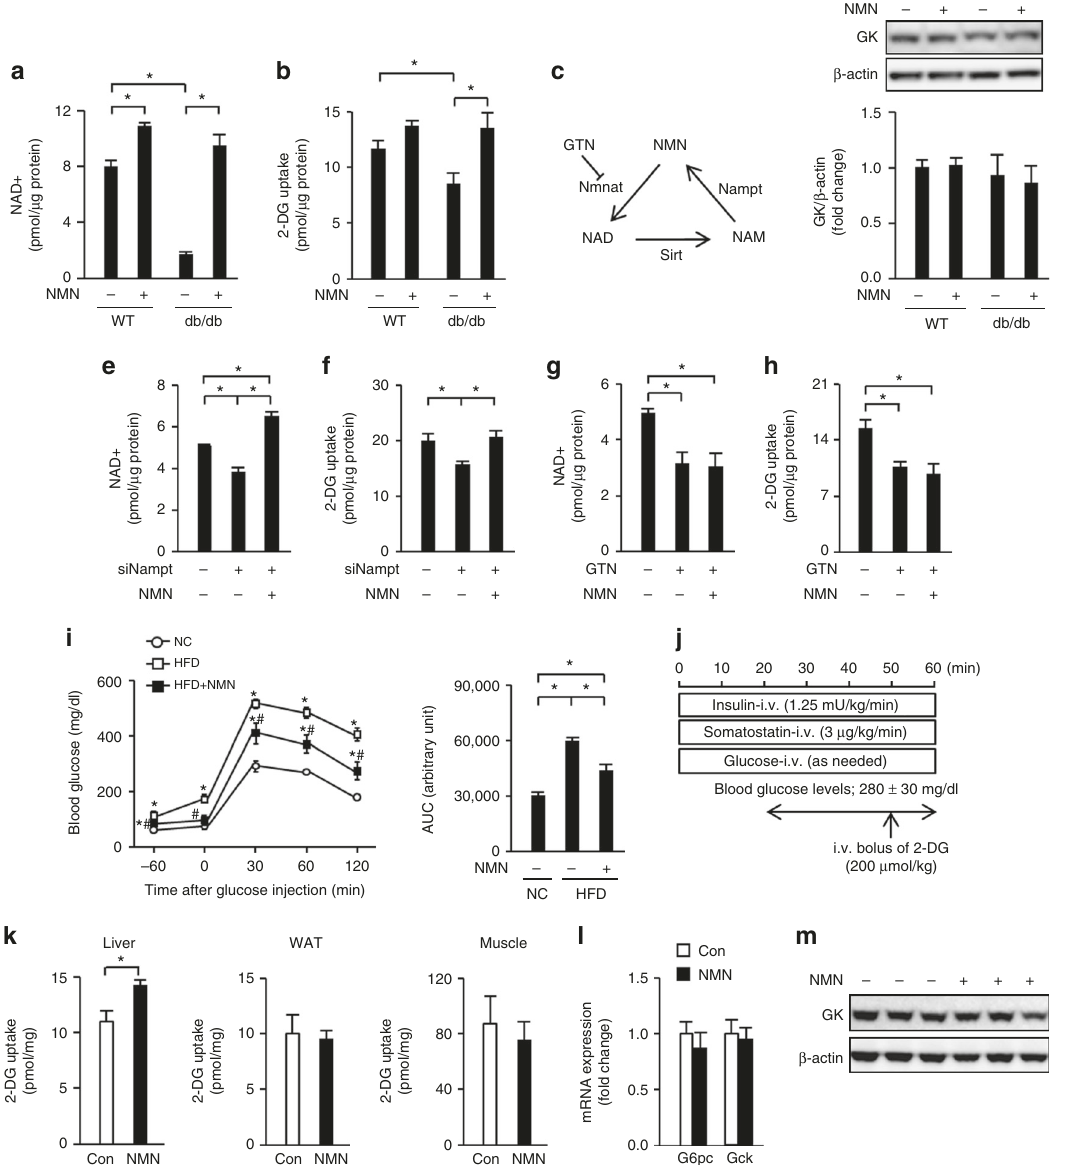
Fig. 1 NAD+ restoration increases glucose uptake in steatotic hepatocytes. a , b NAD+ ( a ) and 2-deoxyglucose (2-DG) uptake ( b ) levels in primary hepatocytes derived from lean control or db/db mice with or without nicotinamide mononucleotide (NMN) ( n = 3). c Schematic representation of NAD+ metabolism. d The protein level of glucokinase (GK) in primary hepatocytes derived from lean and db/db mice ( n = 3). e , f NAD+ ( e ) and 2-DG uptake ( f ) levels in mouse primary hepatocytes treated with siNampt in the presence or absence of NMN ( n = 3). g , h NAD + ( g ) and 2-DG uptake ( h ) levels in mouse primary hepatocytes treated with gallotannin (GTN) in the presence or absence of NMN ( n = 3). i Glucose tolerance testing (1 g/kg) and the area under the curve (AUC) of the glucose tolerance test in normal chow (NC) mice and high-fat diet (HFD) mice treated with or without NMN during continuous dosing with somatostatin ( n = 5). j Hyperinsulinemic-hyperglycemic clamping in HFD mice treated with or without NMN, performed as shown in the schematic. k – m 2-DG uptake levels in the liver, white adipose tissue (WAT), and skeletal muscle of HFD mice ( n = 6) ( k ), hepatic G6pc and Gck mRNA expressions ( n = 6) ( l ), and hepatic GK protein expression ( m ) during hyperinsulinemic-hyperglycemic clamping. * P < 0.05; one-way analysis of variance (ANOVA) with the Fisher ’ s PLSD post-hoc test ( a , b , d – h , i right) and Student ’ s t -test ( k , l ), * P < 0.05, compared with NC, # P < 0.05, HFD vs. HFD with NMN in ( i ) left; one-way ANOVA with the Fisher ’ s PLSD post -hoc test. Data in d , m are representative of at least three independent experiments. Error bars show the standard error of the mean